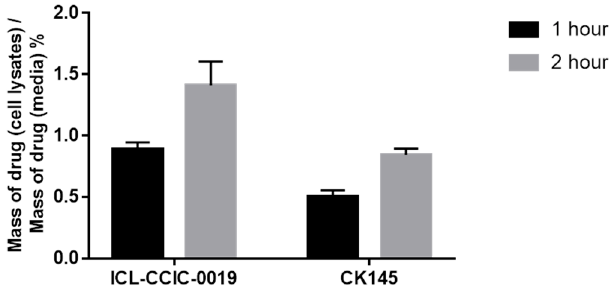
Figure 5. Percentage drug uptake in HCT-116 cell line determined by HPLC at selected time points (1-h and 2-h) ( n = 3, mean ± SD). The data were calculated by the drug amount in cells compared to the initial drug amount in media %; the values represent the percentage of drugs taken into cells.